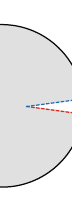
(cid:3) (cid:4)(cid:3) (cid:4) (cid:7) ψ ψ = kZ 2 | ψ | ψ i j j i i , j 1